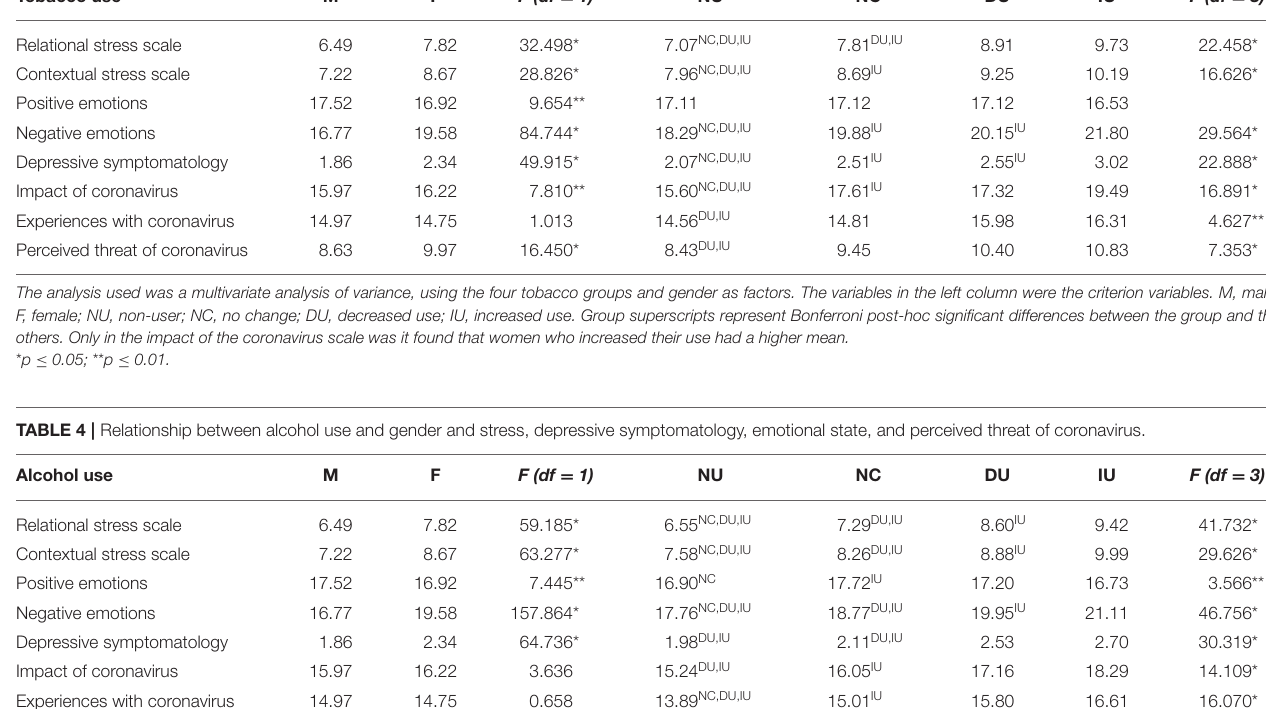
TABLE 3 | Relationship of tobacco use and gender with stress, depressive symptomatology, emotional state, and perceived threat of coronavirus. Tobacco use